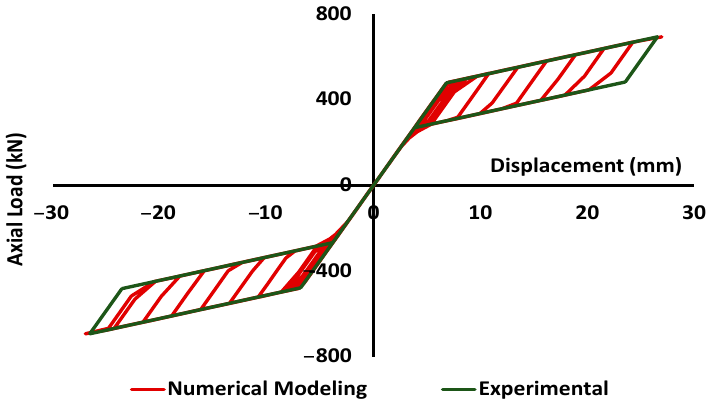
Figure 21. Numerical modeling of SC-BRB versus the experimental response.